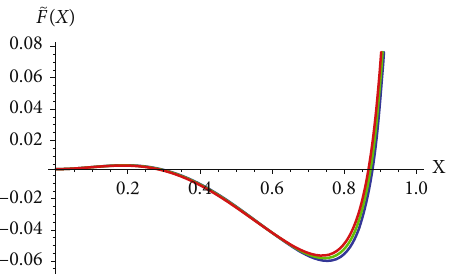
= 0 : 05 , respectively. +